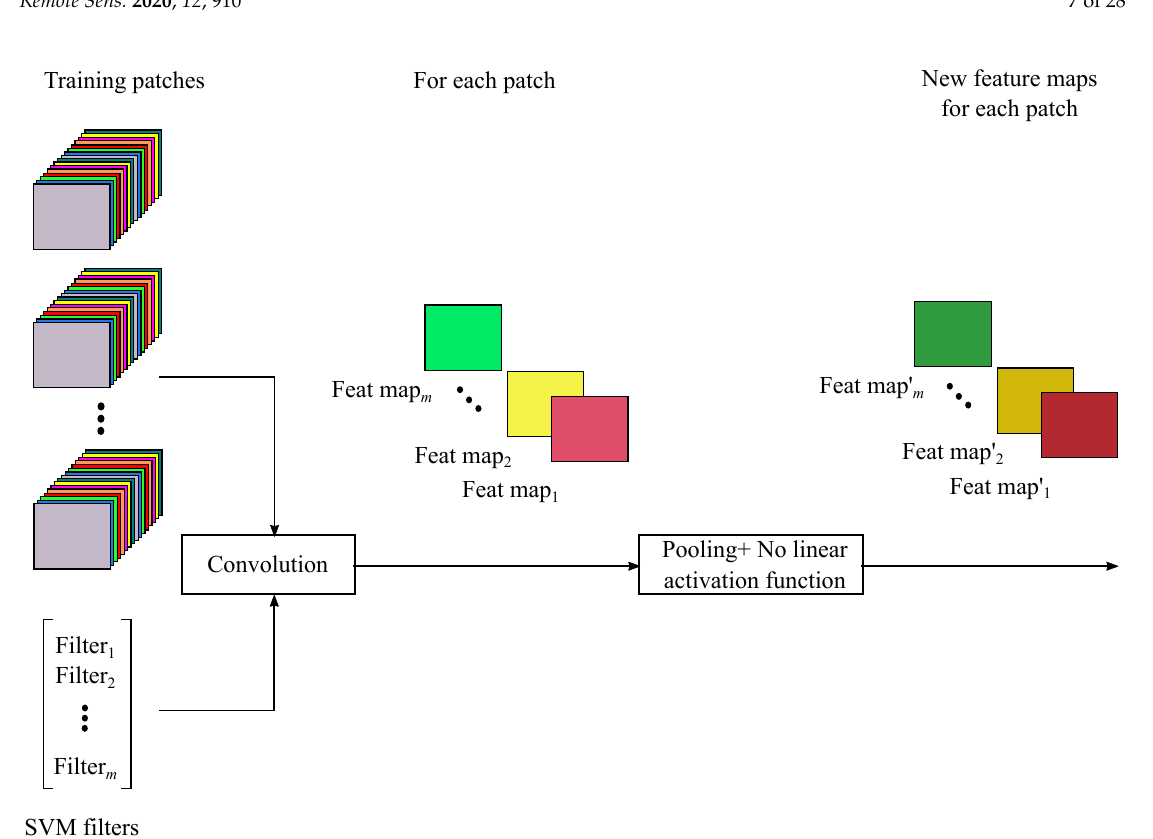
Figure 4. CSVM - Generation of feature